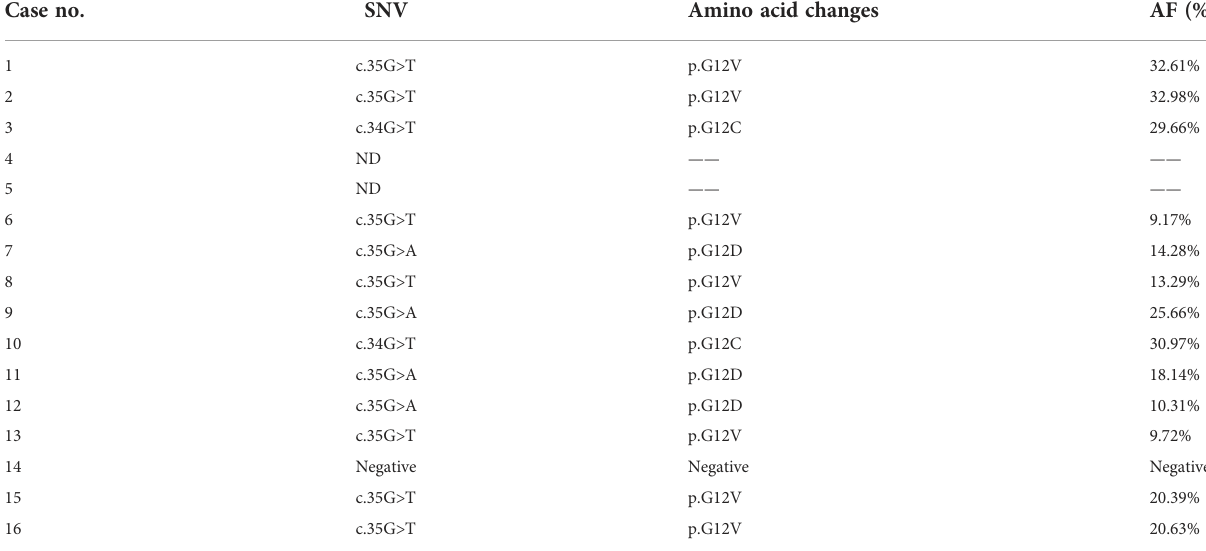
TABLE 3 Targeted next-generation sequencing fi ndings of PRNRP. Case no.